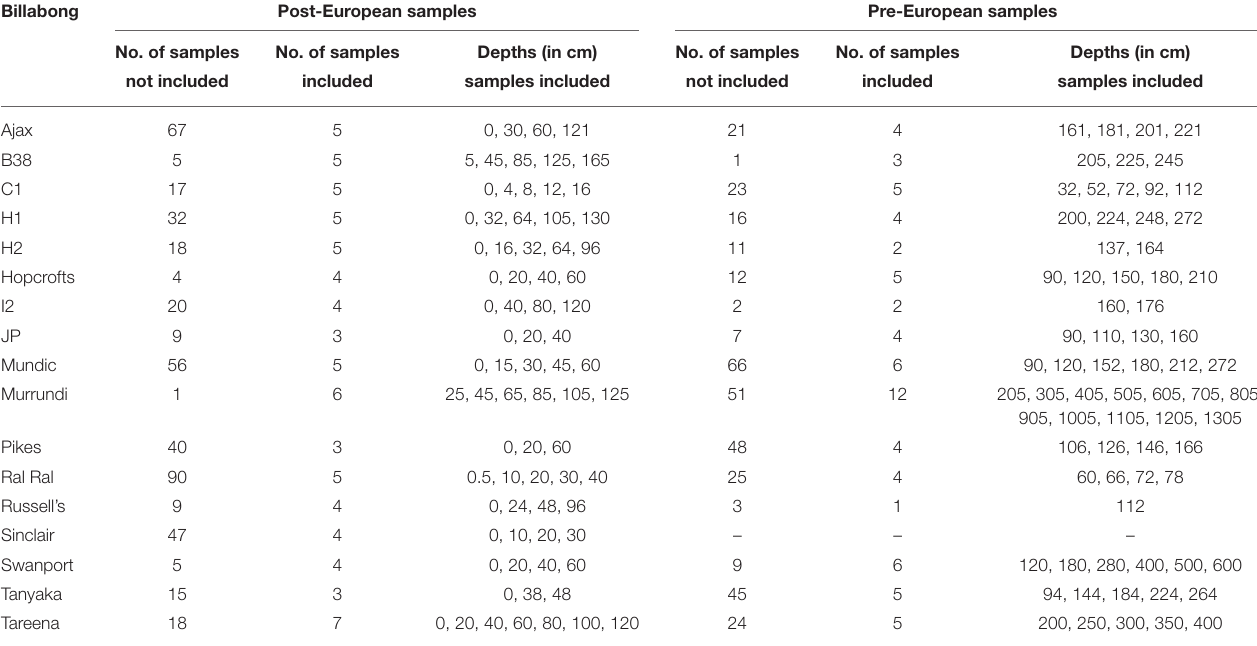
TABLE 2 | Samples included in exploration of interaction between type and era (pre-European vs. Post-European) illustrated in Figure 8. Billabong Post-European samples Pre-European